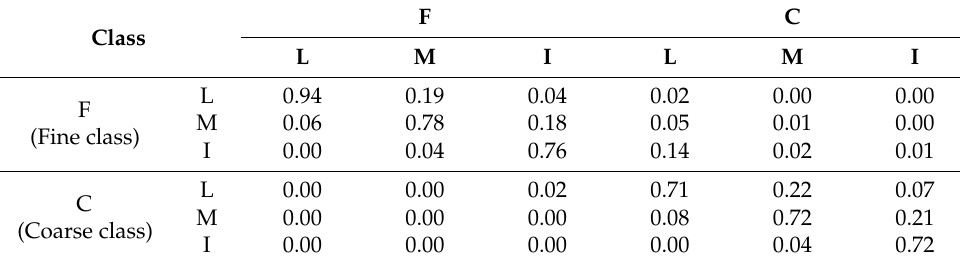
Table A4. Contingency table of tephra classification by